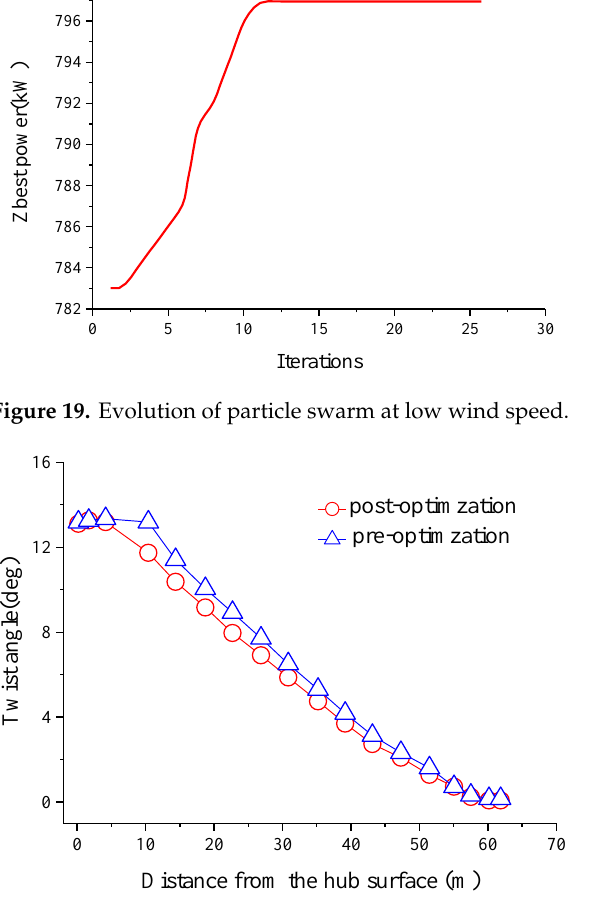
Figure 20. Distribution of the twist angle at low wind speed before and after optimization.